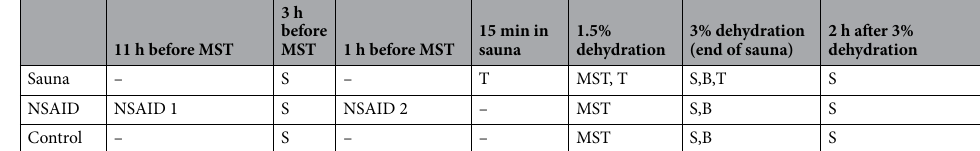
Table 2. Study design. MST multi-sugar test, NSAID 1–75 mg of indomethacin, NSAID 2–50 mg of indomethacin, S-saliva sample, B-blood sample, T-body